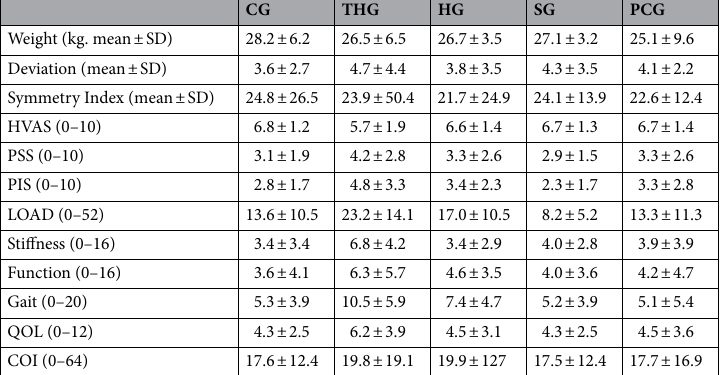
Table 1. Mean values (± standard deviation) at initial evaluation of evaluation conducted for control and treatment groups. CG Control group, THG Triamcinolone hexacetonide group, HG Hylan G-F 20 group, SG Stanozolol group, PCG Platelet concentrate group, HVAS Hudson Visual Analogue Scale, PSS Pain Severity Score, PIS Pain Interference Score, LOAD Liverpool Osteoarthritis in Dogs, QOL Quality of Life, COI Canine Orthopedic Index.